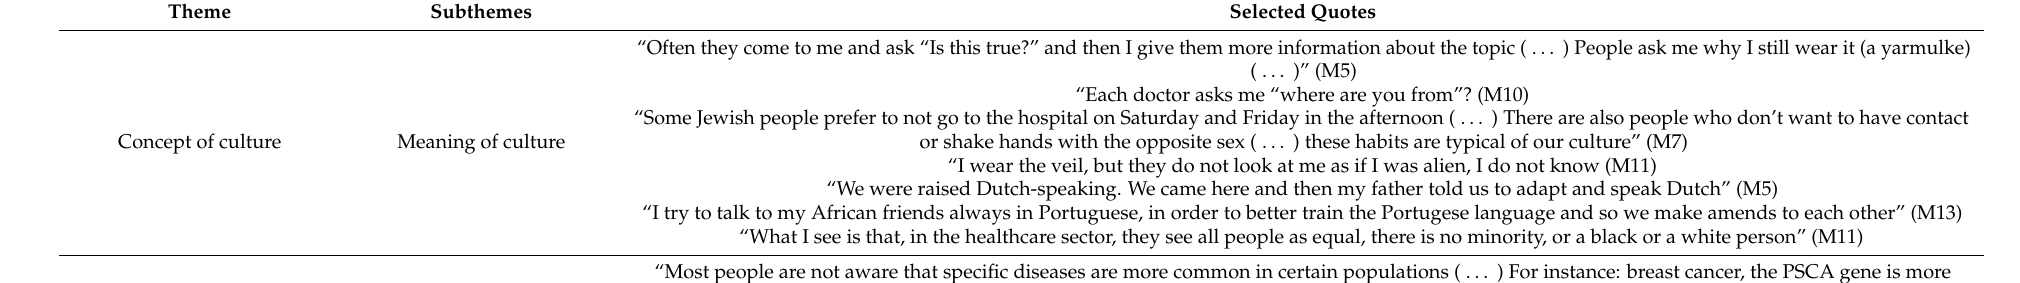
Table A2. Summary of Themes and Subthemes and Example Quotes from the Personal Interviews with MM